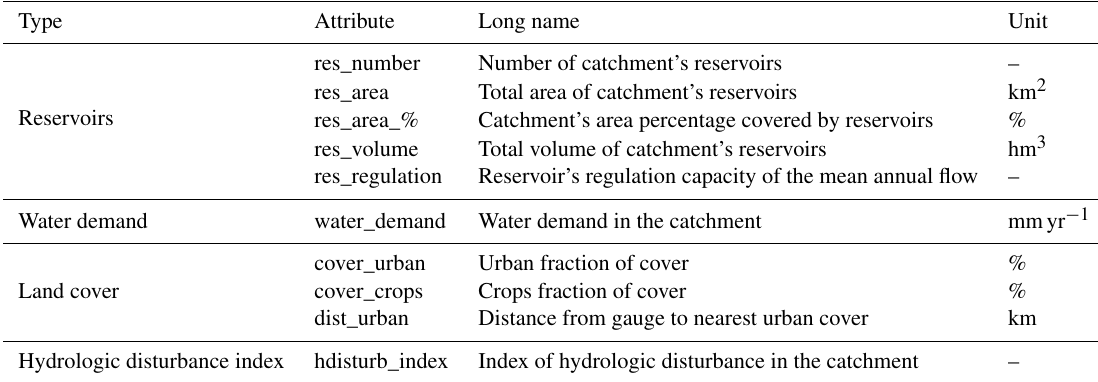
Table 9. Hydrologic disturbance attributes of CABra